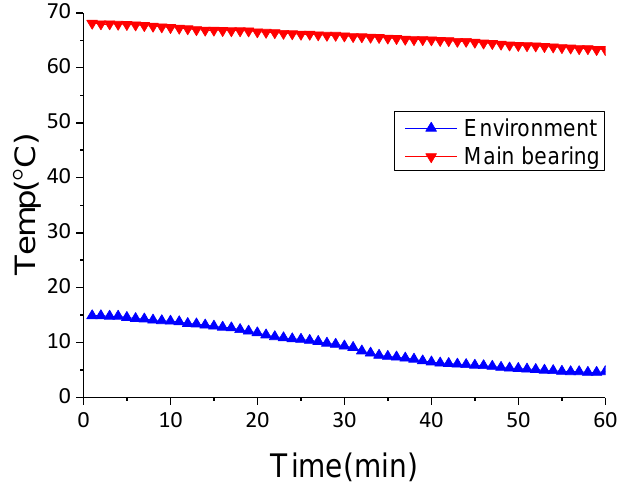
Figure 4. Main bearing temperature during cold wave.